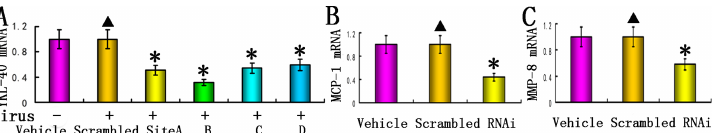
Fig 1. Silencing of YKL-40 in RAW264.7 cells by lentiviral vector-mediated YKL-40 shRNAs. RAW264.7 cells were transduced with 50 MOI of 4 different kinds of shRNA vector, and YKL-40 expression was measured on day 4 by real- time PCR following transduction. GAPDH was used as an internal control. (A) YKL-40 mRNA expression was detected by real-time PCR (n = 8, (cid:3) P < 0.05). (B) RNAi inhibited the expressions of MCP-1 in RAW264.7 cells (n = 8). (C) RNAi inhibited the expression of MMP-8 in RAW264.7 cells (n = 8). No significant difference was found between the vehicle and scrambled groups. Vehicle = vehicle group; Scrambled = scrambled group (negative control). “-” and “+” indicate the absence and presence of lentivirus, respectively. Data are shown as the mean values ± SD obtained from triplicate experiments. (cid:3) P < 0.05 vs. vehicle groups; ▲ P > 0.05 vs. vehicle group.